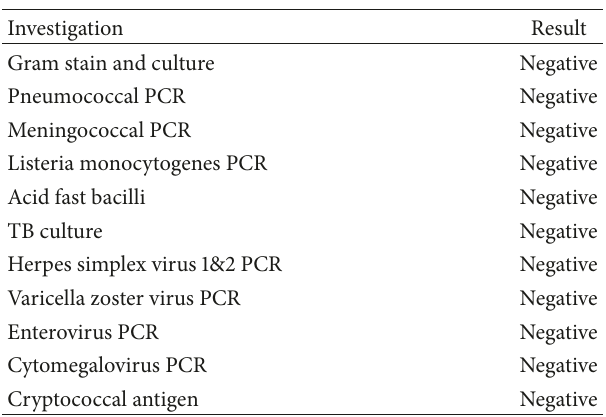
Table 2: Tests of CSF.